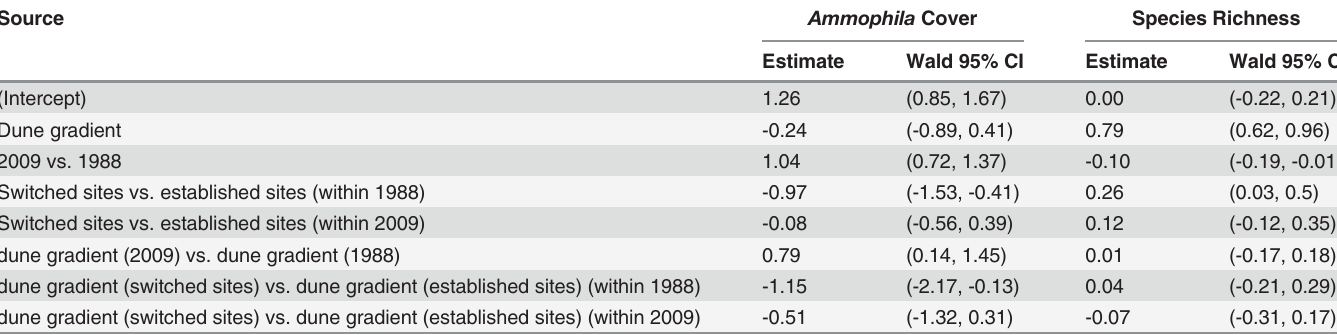
Table 1. Results from the decadal study using linear mixed models with independent linear